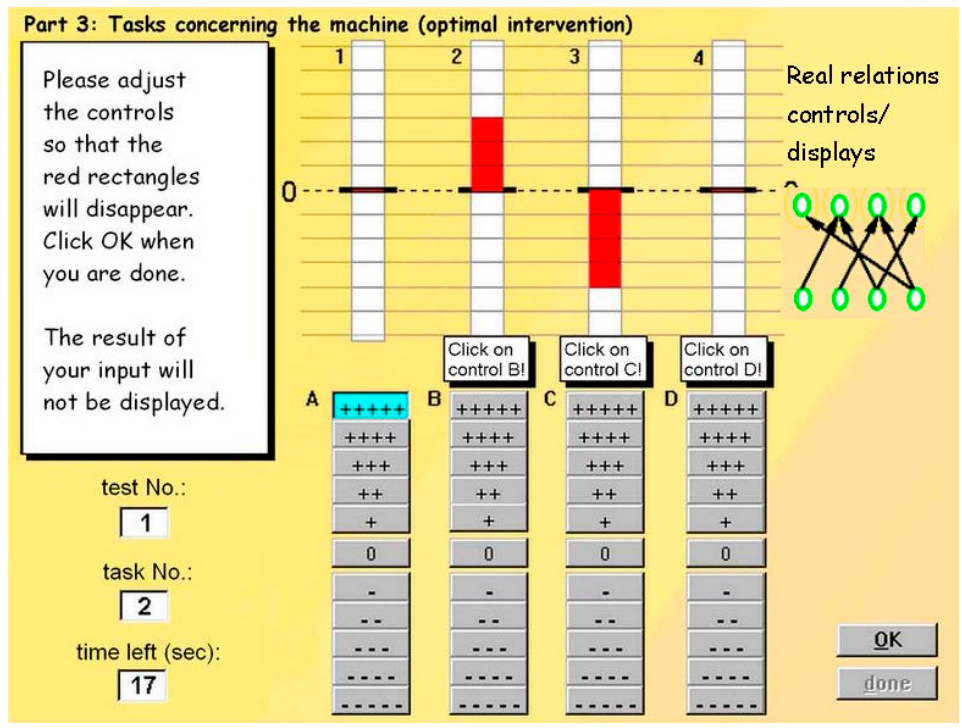
Figure 1. The MultiFlux machine.